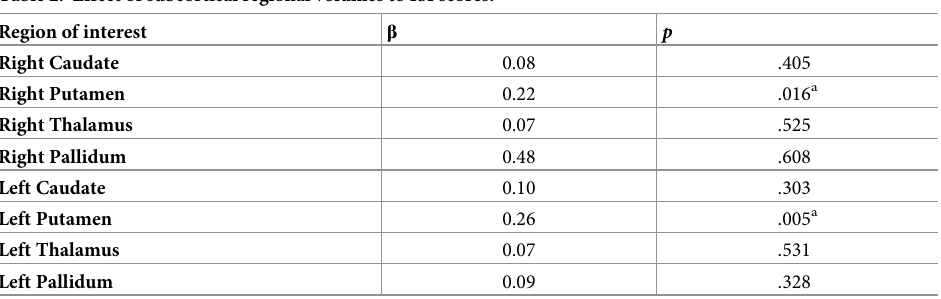
Table 2. Effect of subcortical regional volumes to ISI scores.